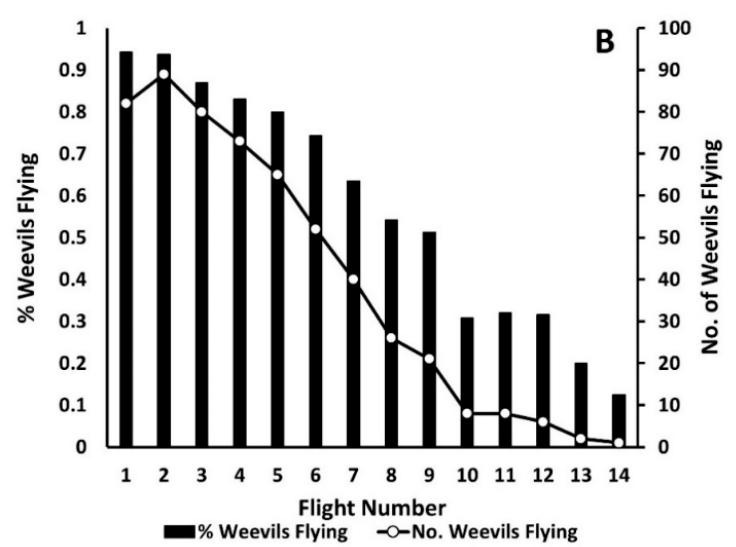
Figure 1. ( A ) Mean (+SE) total distance flown (km) per weevil flight trial and mean flight velocity (m/s) per weevil per flight trial across 14 consecutive flight trials. Data points with different letters or Roman numerals indicate significant differences at the 0.05 level for mean total distance flown and mean velocity, respectively. ( B ) Percentage and number of weevils flying >1 km per flight trial. trial.